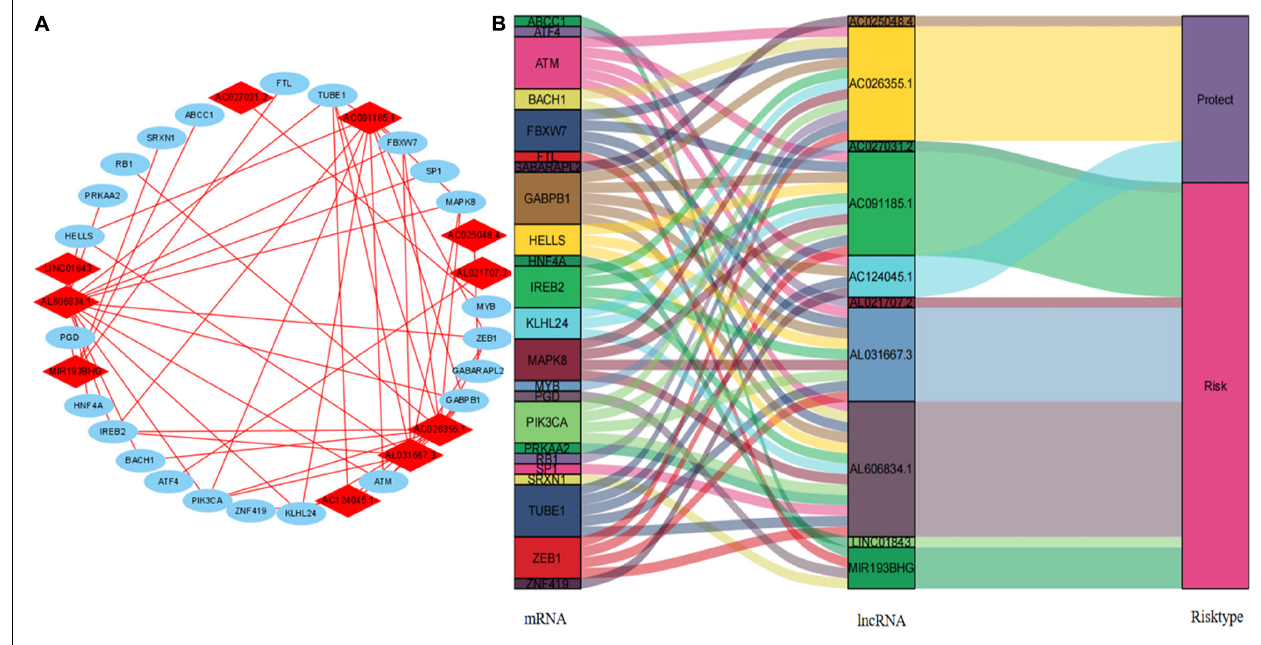
FIGURE 8 | Cytoscape and Sankey diagram of the lncRNA–mRNA co-expression network. (A) Cytoscape map: red and blue, lncRNA and mRNA, respectively. (B) Sankey diagram. lncRNAs, long non-coding RNAs.